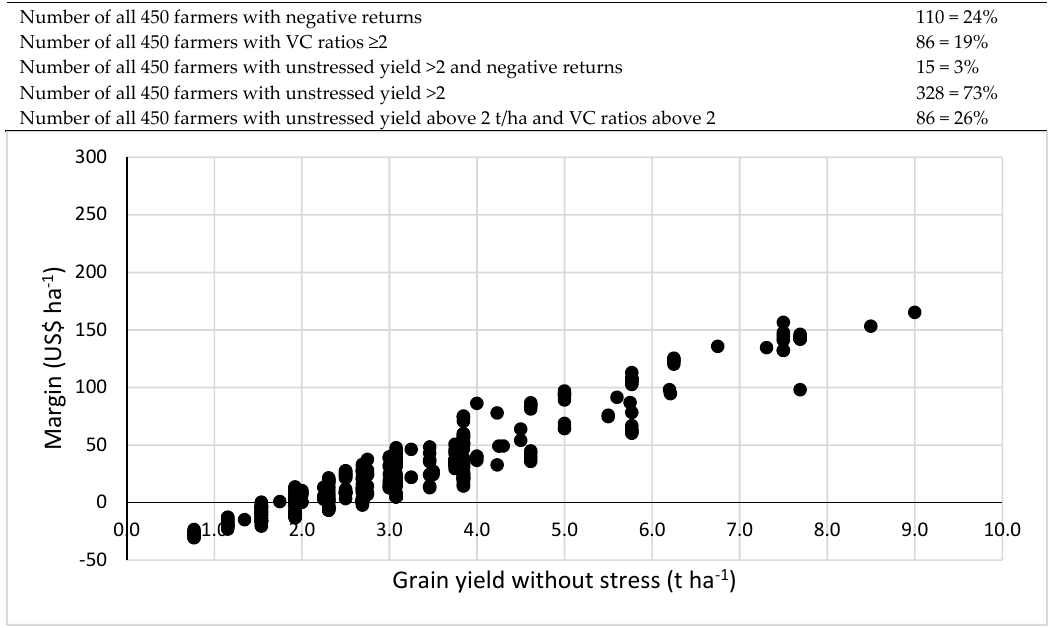
Figure 4. Relation between maize grain yield without stress and the estimated margin of all participating farmers using the drought tolerant genetically modified hybrid maize. Economic performance indicators including the value/cost (VC) ratio are given above the figure.